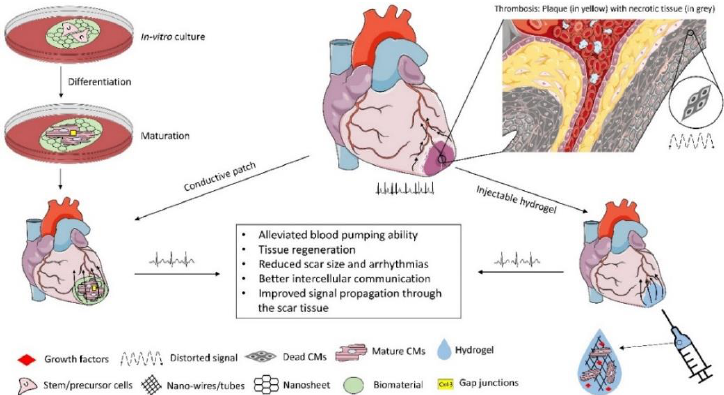
Figure 1. Conductive scaffold-based Cardiac Tissue Engineering. Due to infarction, collagen-rich scar tissue significantly impairs the electrical conductivity of the myocardium. Cell-laden nanomaterial-based conductive constructs can restore the electrical activity of the damaged myocardium with alleviated functions when implanted in-vivo. Some of the figures were adopted from the Servier Medical Art and modified under the CC BY 3.0